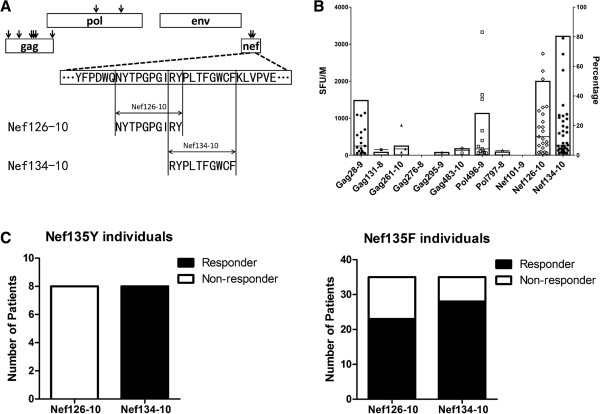
The association between the two overlapping epitopes and the Y135F mutation. (A) HIV-1 map of representative proteins and the locations of HLA-A*24:02-restricted epitopes used in this study are shown (arrow). The positional relation and the sequence information around Nef126-10 and Nef134-10 epitopes are also shown. (B) Immune responses to 11 epitopes were assessed by IFN-γ ELISpot assay by using expanded PBMCs from 46 HIV-1 patients. Epitope names below the chart indicate peptides used in the assay; [Protein][Location(HXB2 numbering)]-[Amino acid length]. Each point represents the average SFU of duplicate wells after subtraction of background in each individual. Each stick represents response rate in 46 individuals. (C) The Nef126-10/Nef134-10-specific response rates among individuals harboring either Nef135Y or Nef135F were assessed. Black bars indicate number of responders to each epitope, and white bars for non-responders.